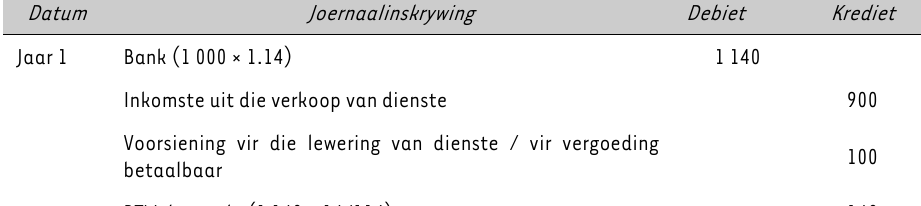
TABEL 5: Algemene joernaalinskrywings van die lugredery